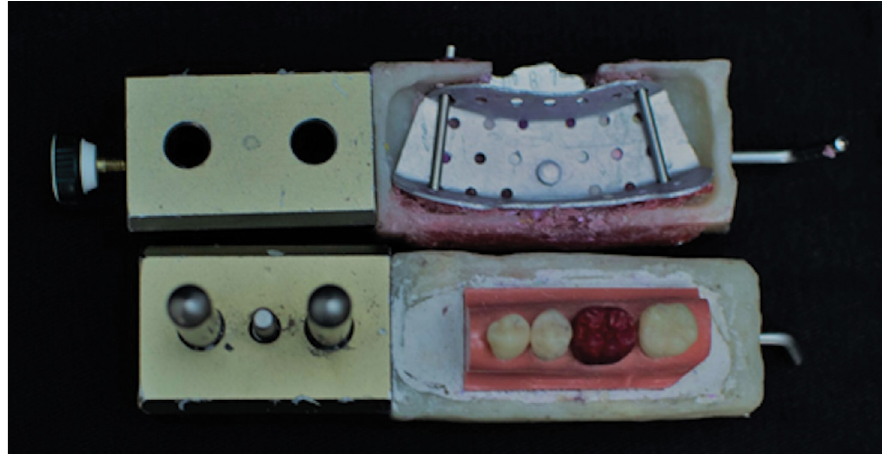
Figure 2. The partial stock tray and standard crown on the metal die in the left mandibular hemi-arch. Both were adapted to the upper and lower parts of the verticulator,